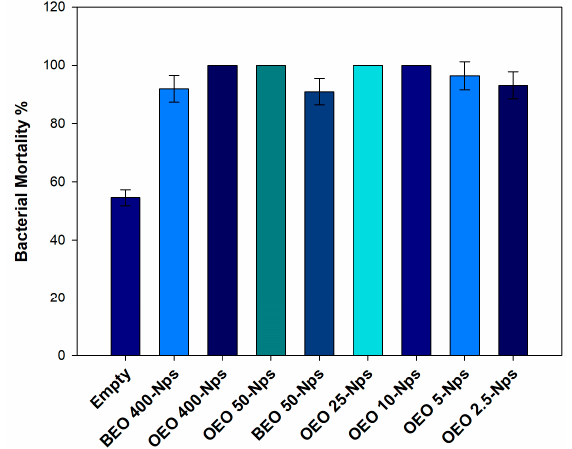
Figure 9. Bacterial mortality of E. coli after 24 h incubation at 37 °C with empty NPs and NPs-loaded EOs. Data represented as a percentage are the results of six different tests compared to the control (untreated E. coli ).